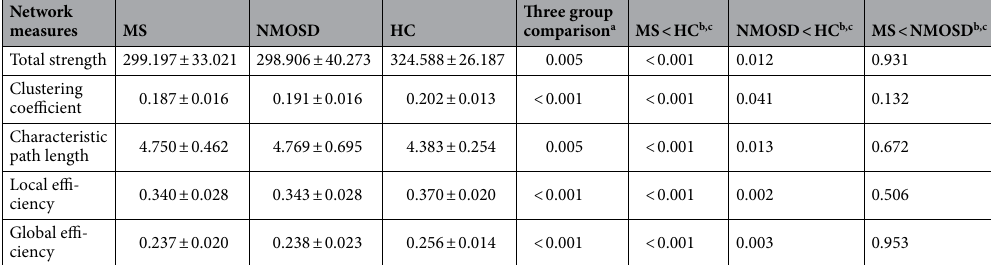
Table 2. Comparison of global network topological measures between MS, NMOSD and HC groups. MS multiple sclerosis, NMOSD neuromyelitis optica spectrum disorder, HC healthy control; Data area expressed as mean ± standard deviation. a p values from the permutation-based ANCOVA controlling for age and sex between three groups (MS, NMOSD, HC). b A < B, decreased values in A relative to B. c FDR adjusted p values of post-hoc tests based on the permutation based ANCOVA controlling for age and sex.